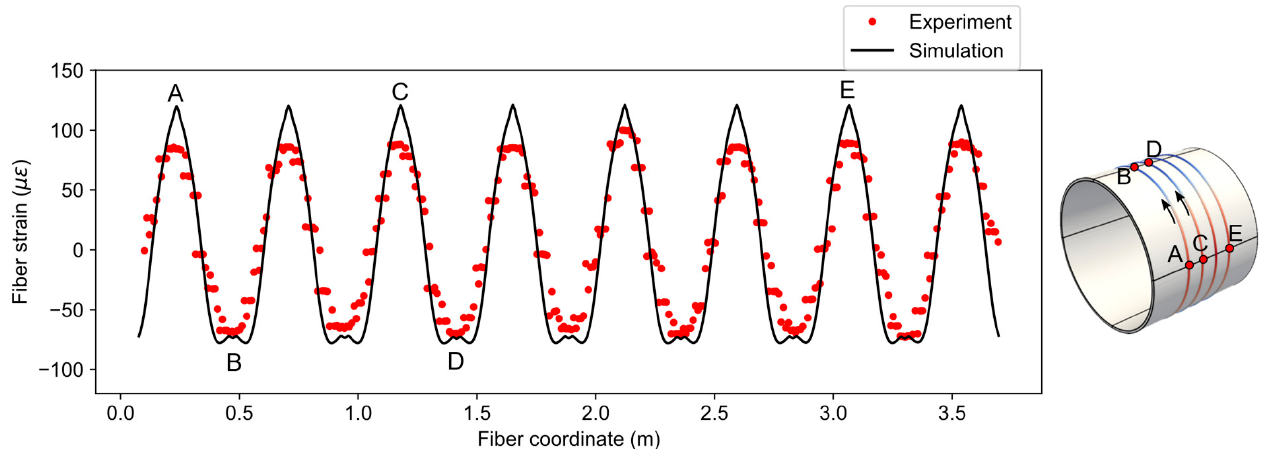
Figure 12. Comparison of fiber strains between simulation and experiment for u = 534 µ m.